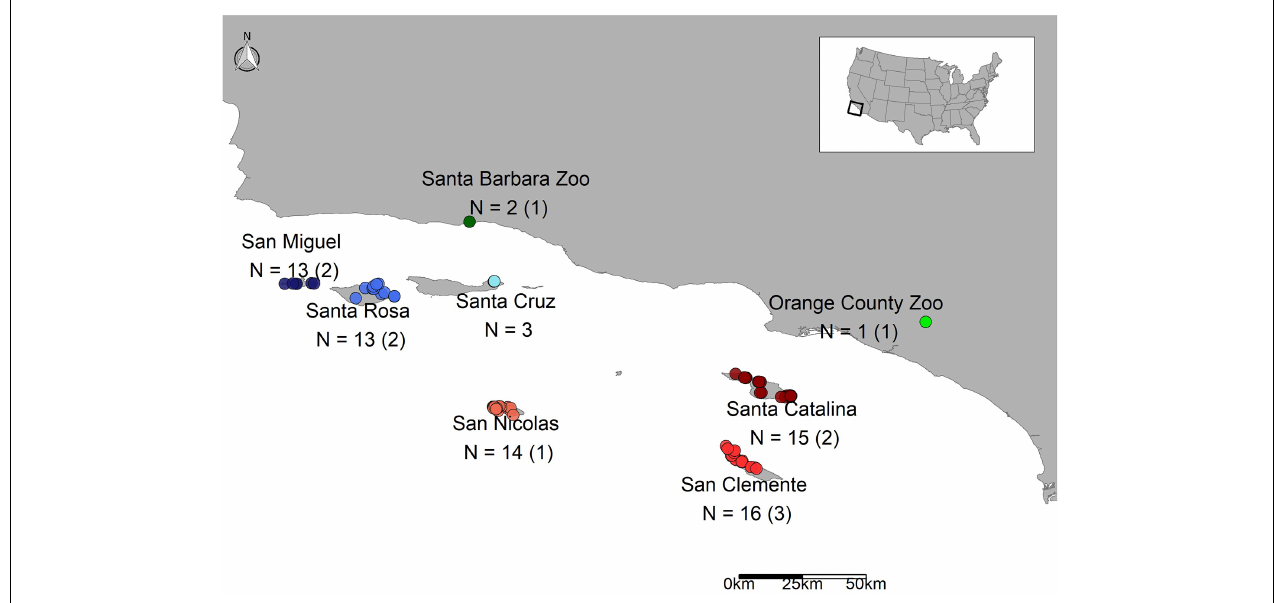
FIGURE 1 | Map of scat samples across the Channel Islands and the mainland. The sample sizes are listed followed by the number of replicates, which are listed in